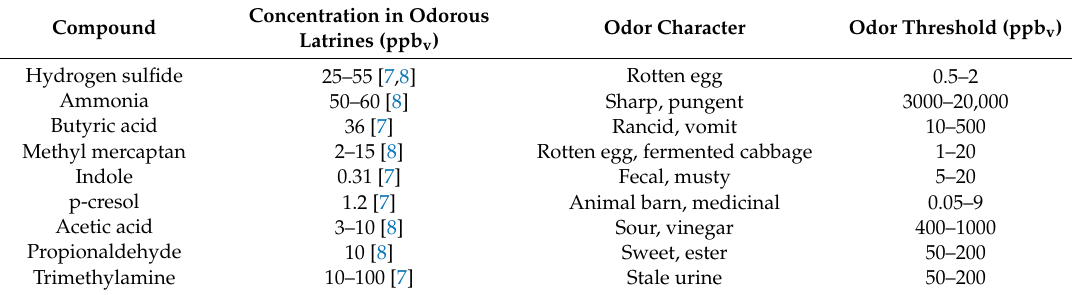
Table 1. Major odorous compounds found in toilets and latrines, their typical smell, and commonly reported odor threshold. The latter often vary by many orders of magnitude, thus average commonly reported values were